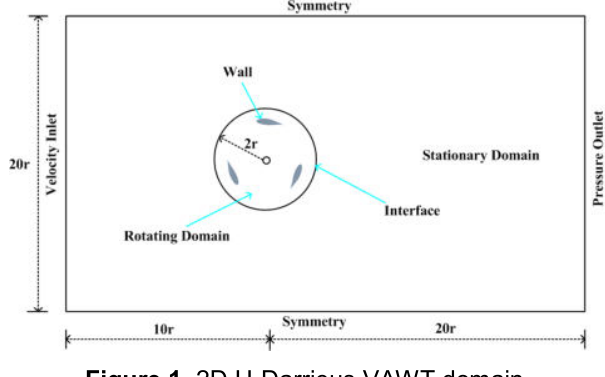
Figure 1. 2D H-Darrieus VAWT domain.